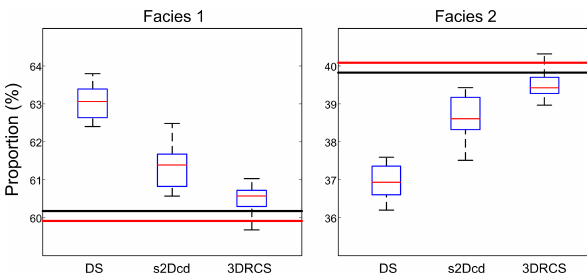
Figure 10. Proportions of the facies for 20 reconstructions by using three MPS methods. The black and red horizontal lines represent the proportions of facies in the 3-D reference and the cross sections used as training images respectively.